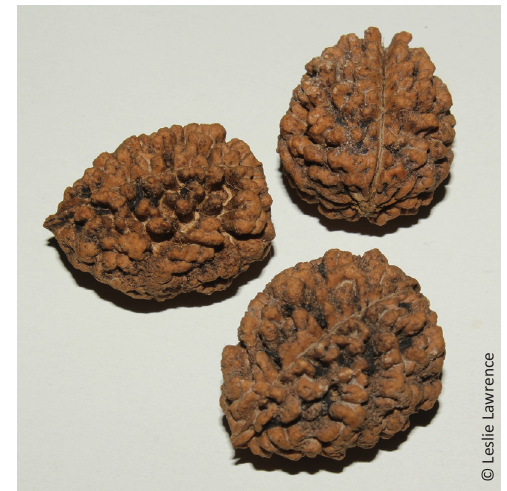
Image 3. Seeds of E.